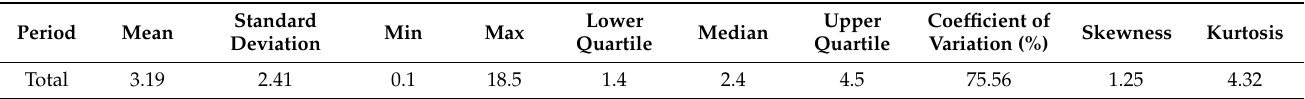
Table 3. Descriptive statistics of the whole